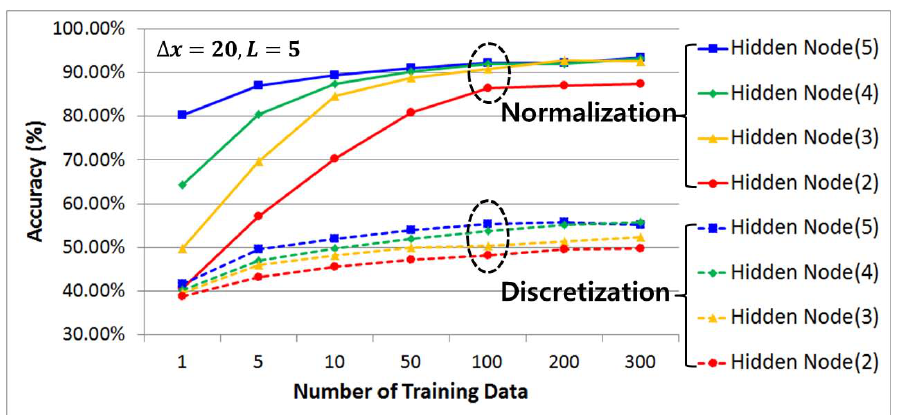
Figure 14. ( ∆ x = 20, L = 5) Comparative analysis of prediction accuracy per data preprocessing technique using historic data, the number of hidden layers, and the number of training data.